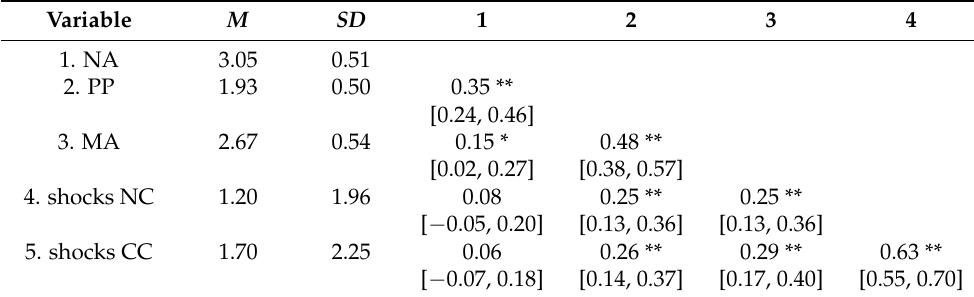
Table 5. Means, standard deviations, and correlations with confidence intervals.